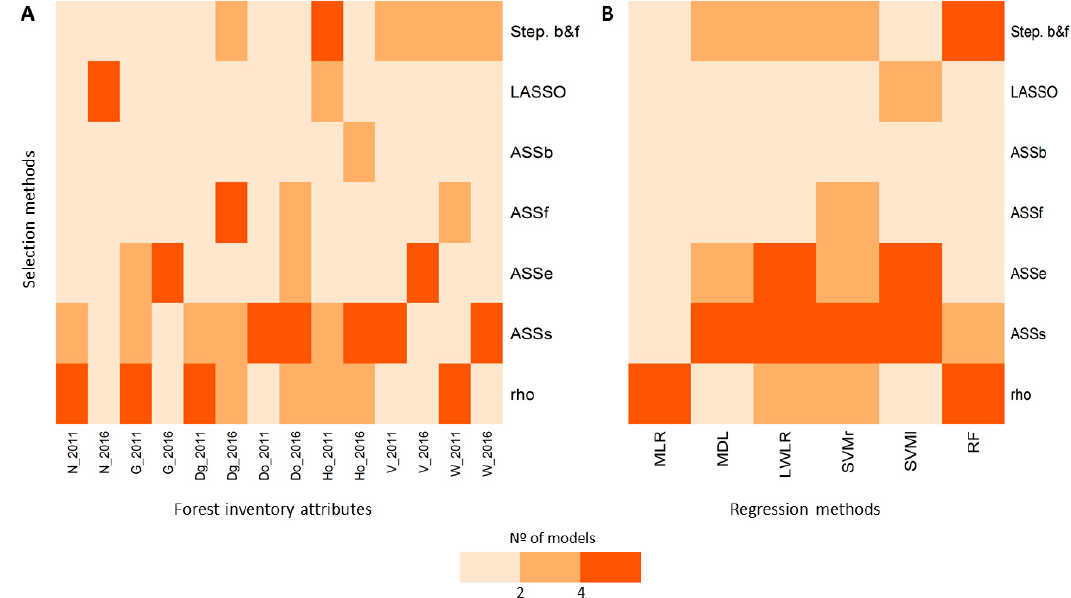
Figure 3. Performance of selection methods for each forest inventory attribute by year (3A) and performance of selection techniques for each regression method without considering the year of the model (3B). Maximum number of computed models in Figure 3A was six for all the stand attributes except for volume (V) and total tree biomass (W), which have a maximum number of five models. Maximum number of models in Figure 3B is 14, seven for each year and stand attribute, for all regression methods. Rho stands for Spearman Rank; ASSs stands for All Subsect Selection Seqrep; ASSe stands for All Subsect Selection Exhaustive; ASSf stands for All Subsect Selection Forward; ASSb stands for All Subsect Selection Backward; and Step. b&f stands for Stepwise Selection Both Backward and Forward.